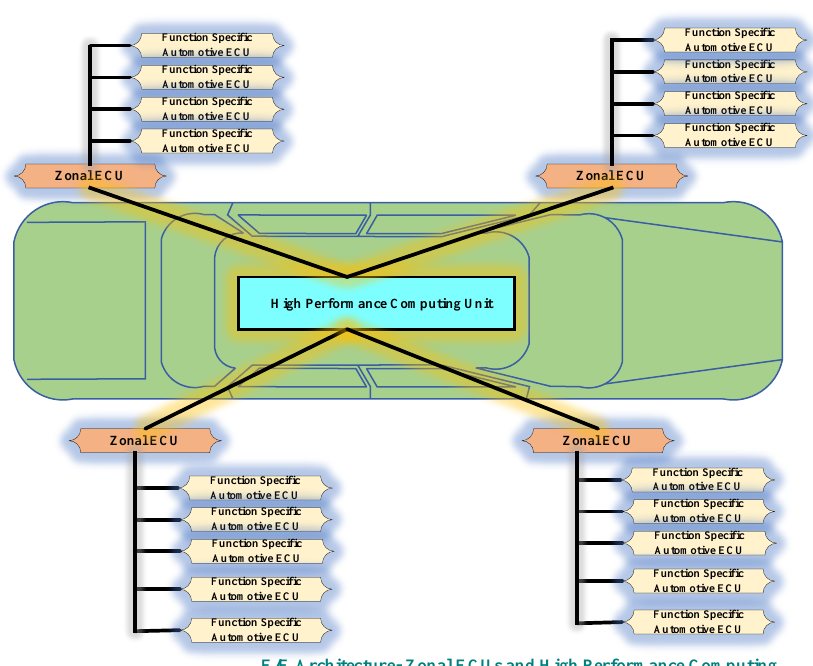
Figure 5. E/E Architecture-Domain Centralized.